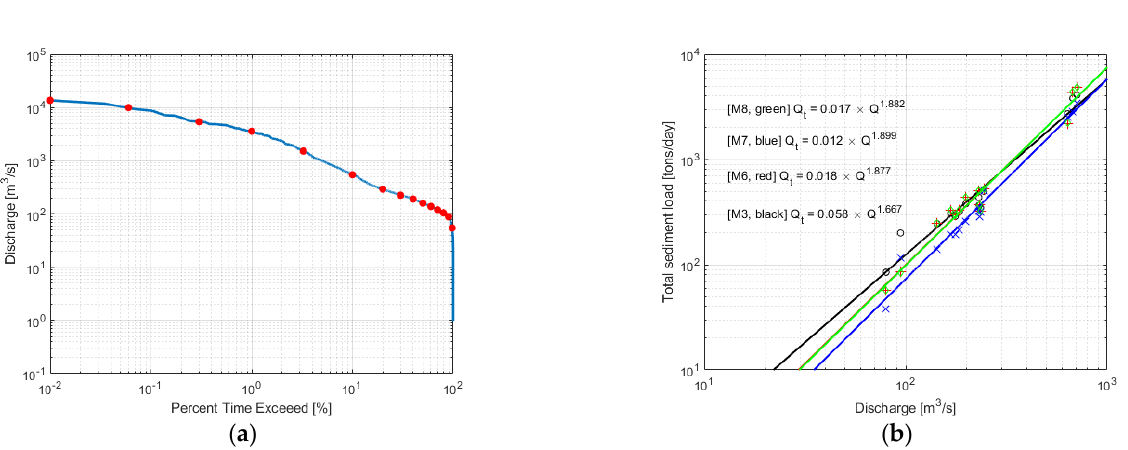
Figure 10. ( a ) Flow duration and ( b ) sediment rating curves from the predicted total sediment load from models M3, M6, M7, and M8 at the Jeokpo Bridge.